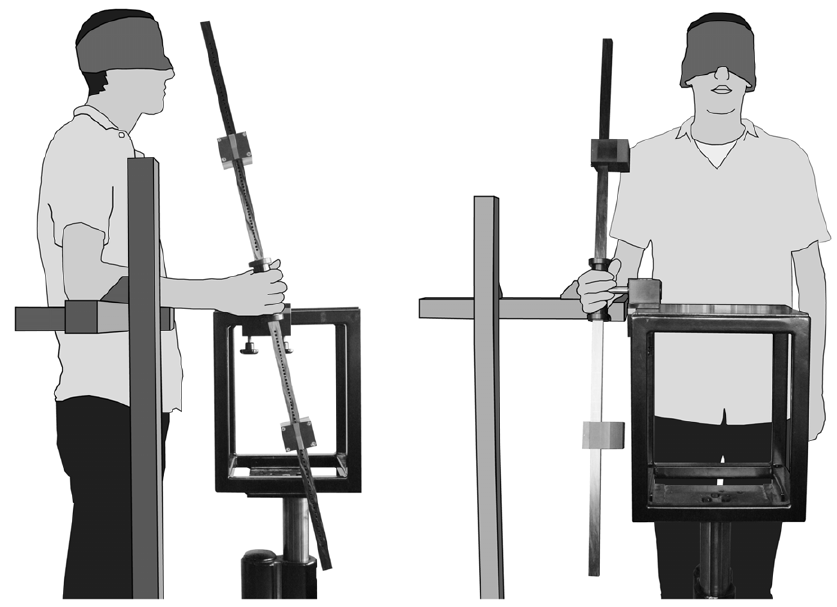
Figure 2. Experimental setup. The setup is illustrated from a side view (left) and a frontal view (right). The rod had one degree of freedom, which allowed rotation to and away from the body. These rotations were made by abduction and adduction of the wrist. Not shown in this figure are the Optotrak cameras and the two markers that were used to record the rod’s movements. body and their right forearm on a horizontal armrest. The height of the armrest was customized to the individual participants. The rod was mounted on a heavy pole that was fixed firmly to the ground. The pole’s height could be adjusted such that the rod’s the center of the wrist) for each individual participant. Participants